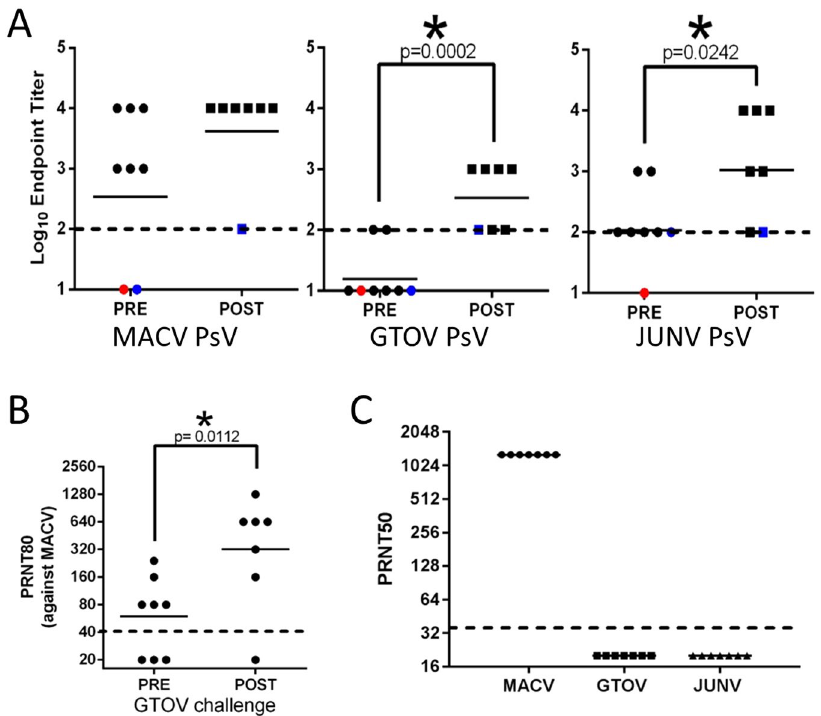
Figure 6. Binding and neutralizing antibody responses in guinea pigs infected with GTOV. ( A ) Antibody binding titers were determined by coating 96-well plates with the indicated PsVs and incubating them with serially diluted antiserum samples from before (circles/PRE) or after (squares/POST) challenge with GTOV. The dashed line denotes the limit of detection. The red circle denotes the single animal (Animal #4) that succumbed to infection. The blue symbols denote the same animal before and after GTOV challenge. Note that titers against MACV prior to GTOV challenge are also depicted in Fig. 4B. ( B ) PRNT80 titers against MACV (Car 68 ) prior to and after challenge with GTOV were determined as above. Note that PRNT80 titers prior to GTOV challenge are also depicted in Fig. 4C. ( C ) PRNT50 titers against JUNV, MACV and GTOV were determined as in Fig. 2. Titers were determined as described above. The dashed line indicates the limit of detection. For all panels, asterisks denote statistical